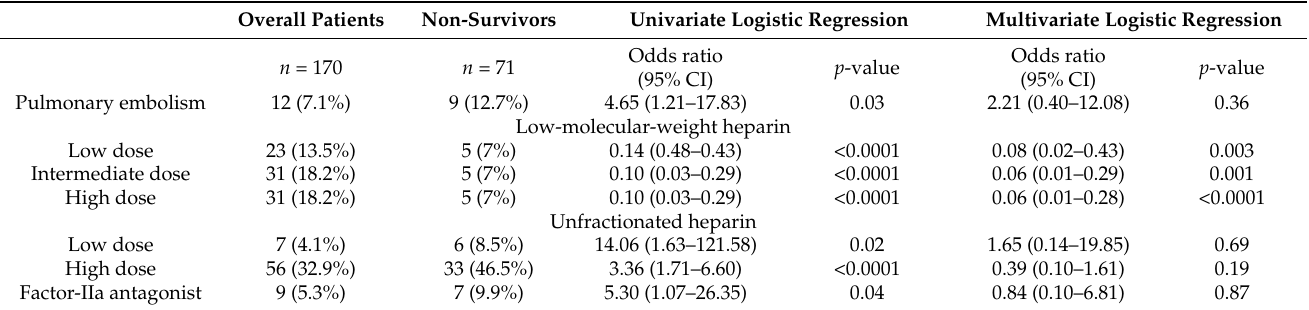
Table 4. Anticoagulation regimes of consecutive COVID-19 patients admitted to the Department of Intensive Care Medicine (University Medical Center Hamburg-Eppendorf, Germany) are illustrated ( n = 170). Anticoagulation therapy was evaluated within the last 24 h prior to death. Patients were grouped according to their overall survival. Numbers with frequencies and median with interquartile ranges are illustrated. Univariate and multivariate logistic regressions were performed. Odds ratios with 95% confidence intervals are given. Model estimators: Wald chi-square test: 39.13, p < 0.0001; Akaike’s information criterion (AIC):